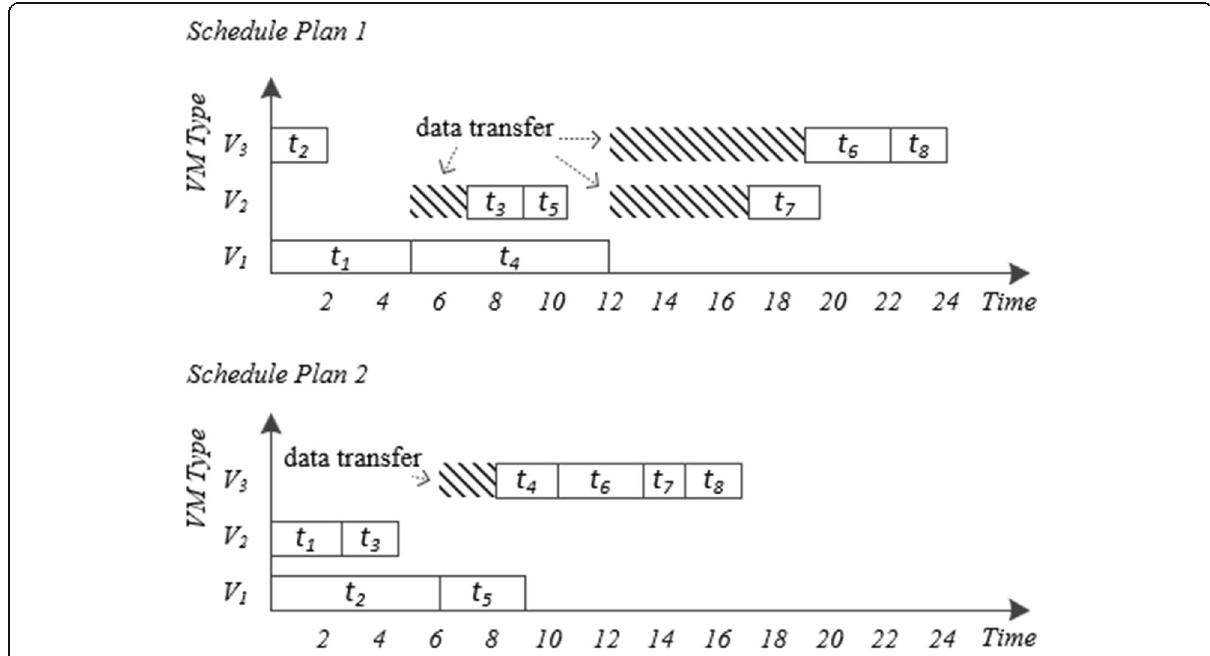
Fig. 2 Schedules of the workflow from Fig. 1 with different task assignment